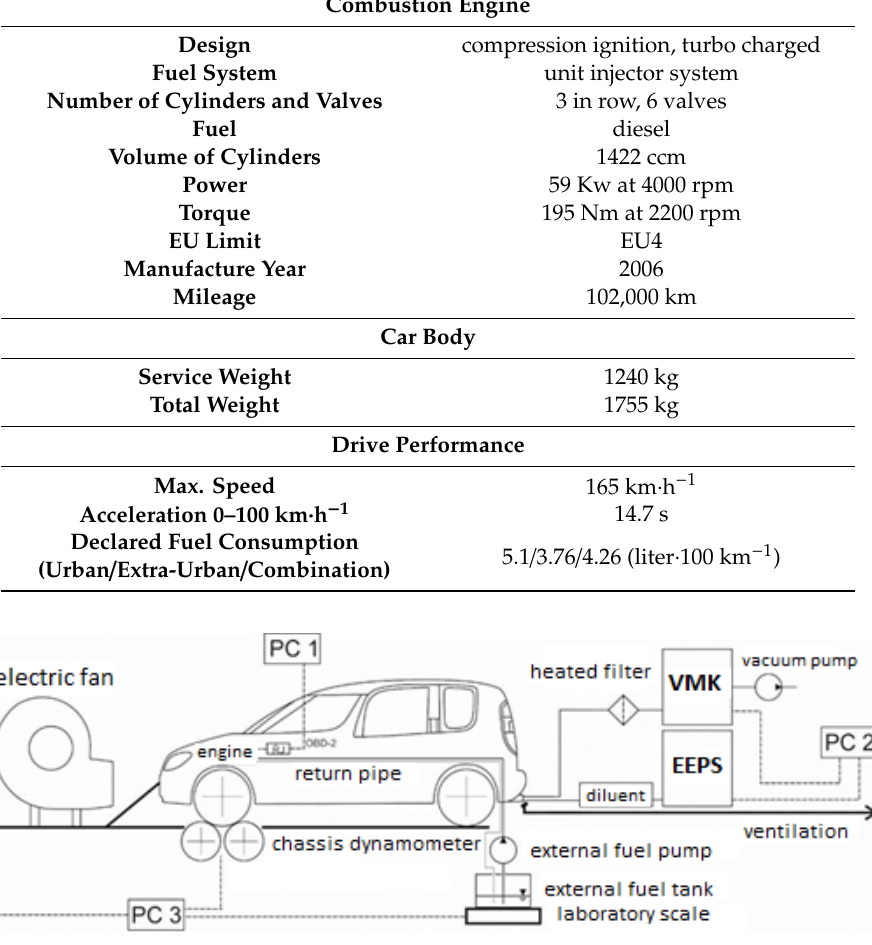
Figure 1. Schema of experiment.